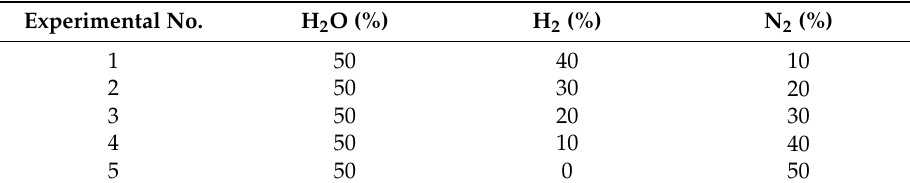
Table 4. Experimental arrangement of bituminous char gasification in the mixture of H 2 O, H 2 , and N 2 . Experimental No.